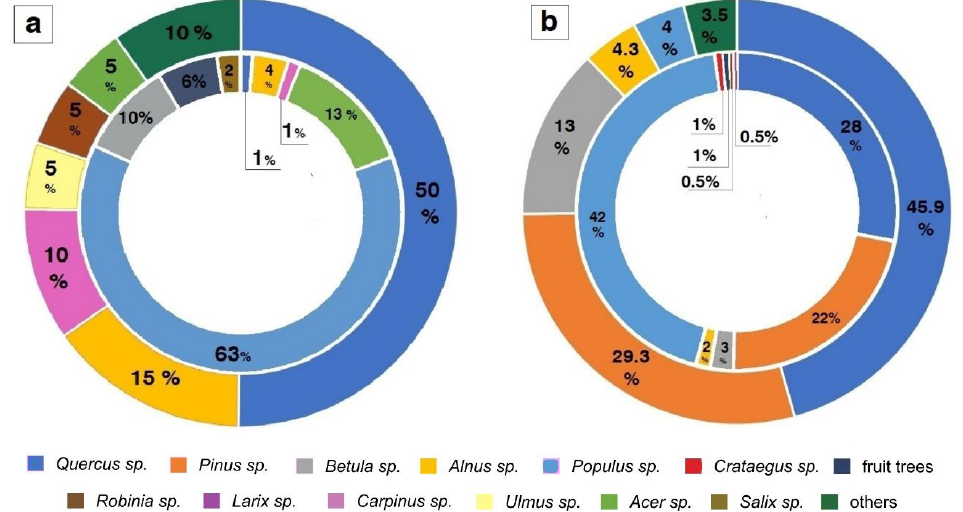
Figure 3. Percentage of defoliated trees (inside ring) on the background of all trees of the forest (outside ring), ( a ) —the Bielański Forest , ( b ) —the Kabacki Forest (author’s elaboration based on Database of the High Structural Diversity Tree Crown Map for Warsaw).